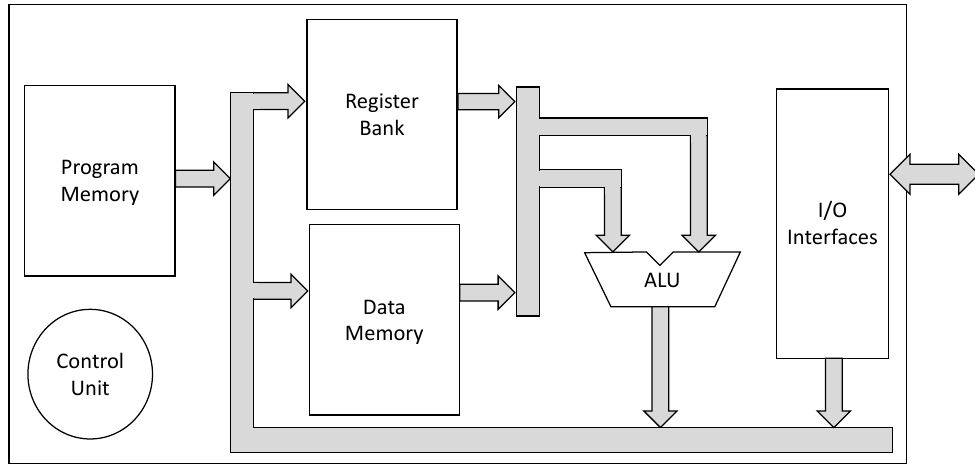
Figure 1. Basic organization of the proposed microcontroller